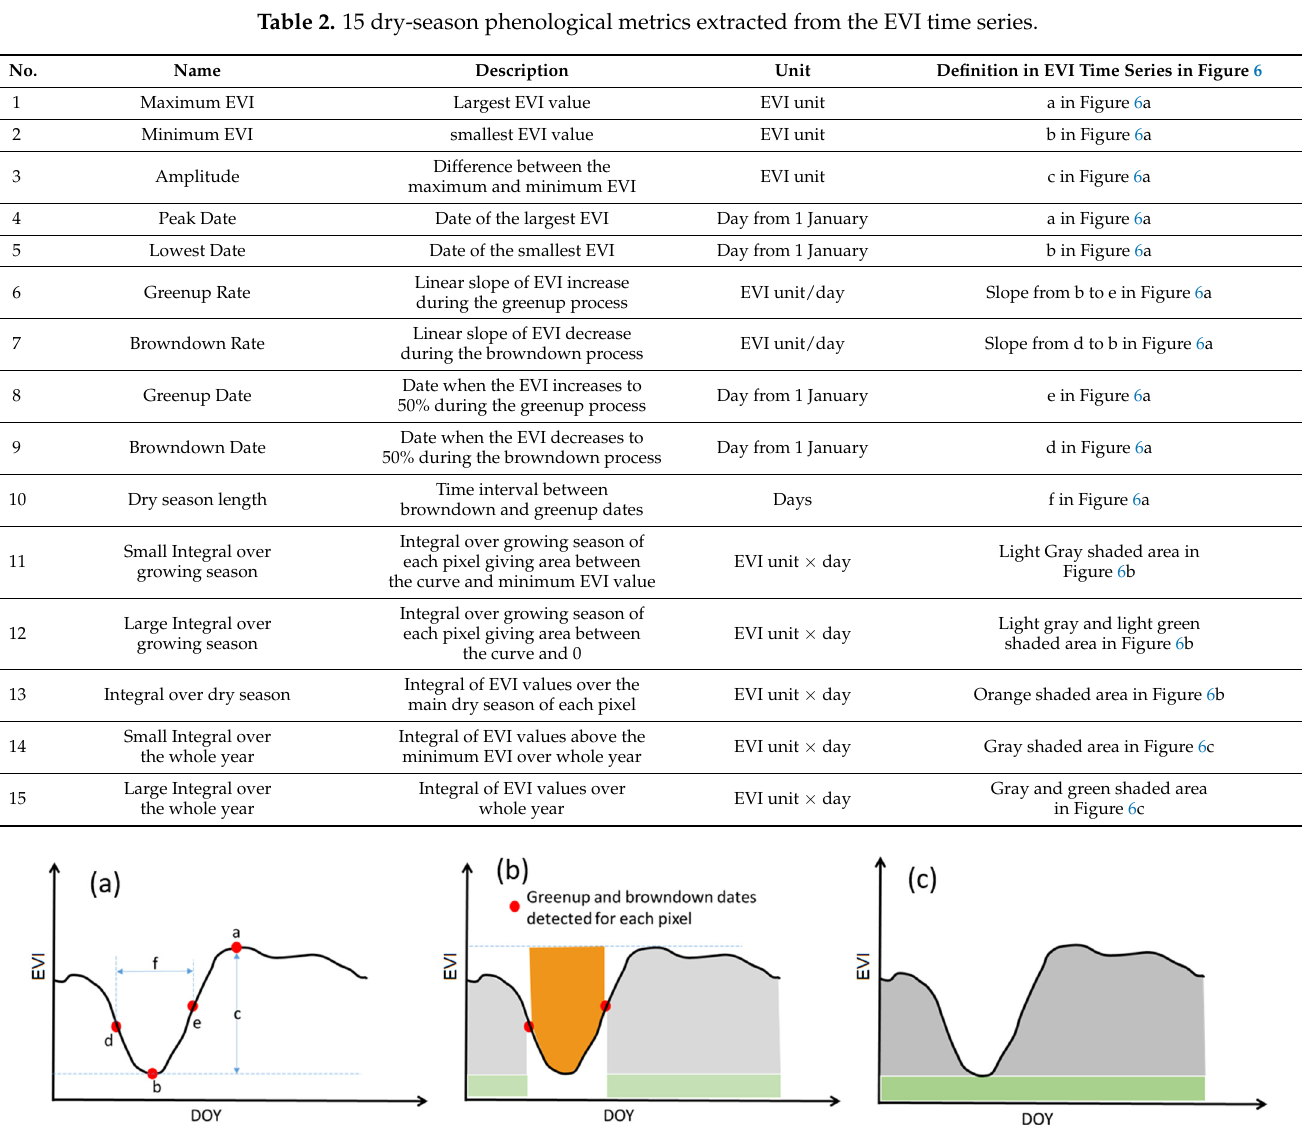
Figure 6. Definition of dry-season phenology metrics in the enhanced vegetation index (EVI) time series: ( a ) a–f are maximum EVI, minimum EVI, amplitude, browndown date, greenup date, and dry season length; ( b ) the light gray shaded area is the small integral over growing season, the orange shaded area is integral over dry season, and the total of light gray and light green shaded area is large integral over growing season; and ( c ) the gray and green shaded areas are small and large integral of the whole year, respectively.